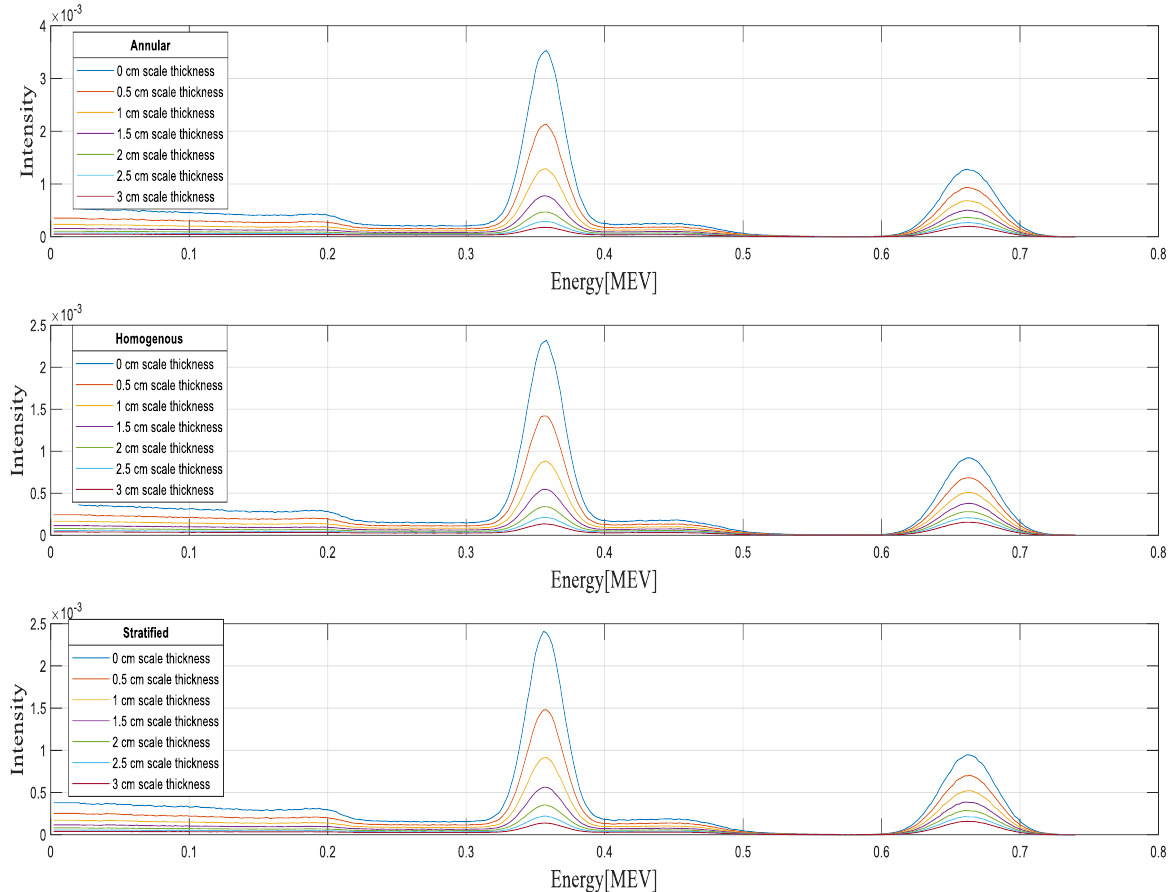
Figure 2. ( a ) Structure of proposed configurations discussed in the study, ( b ) simulated flow re- gimes.